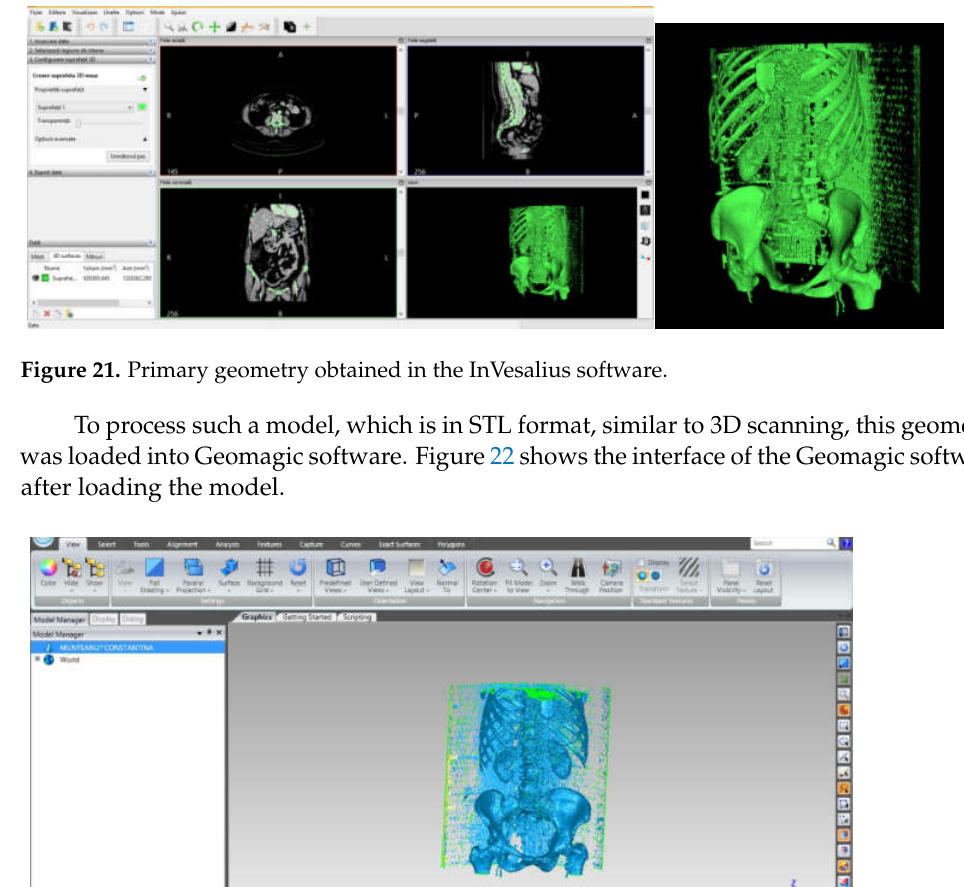
Figure 20. Micro fissures in the orthopaedic prosthesis analysed under the microscope.